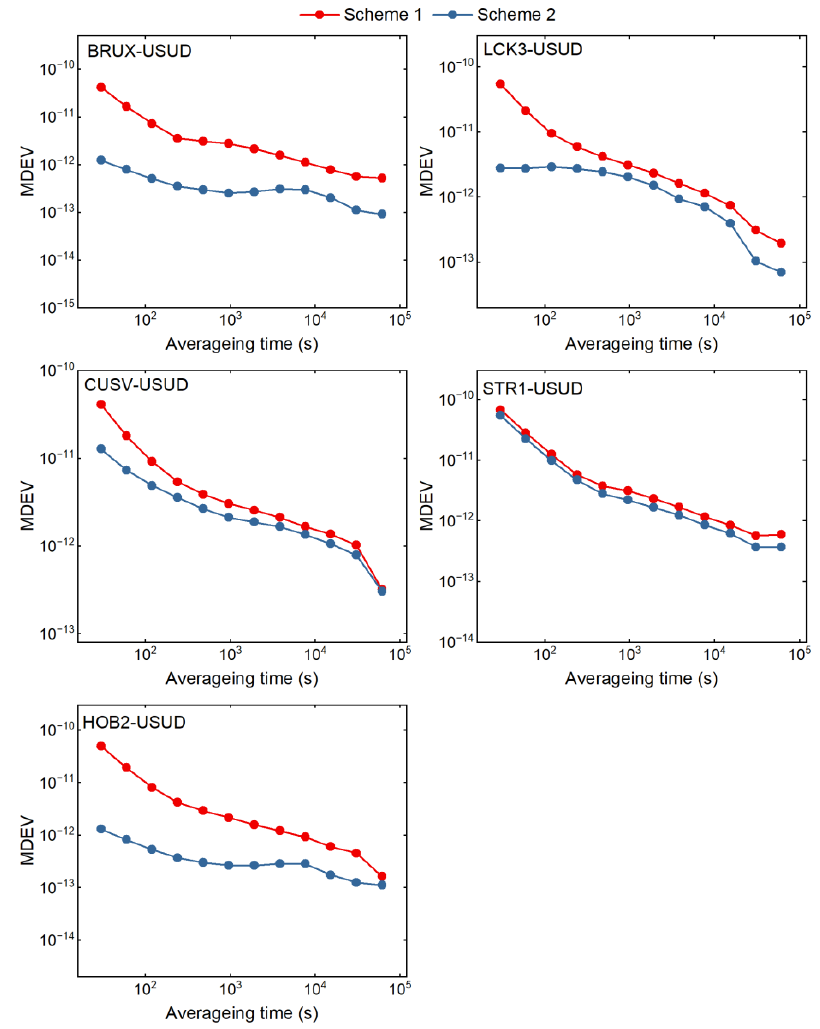
Figure 14. MDEVs of the SF SPP solutions for each time link.